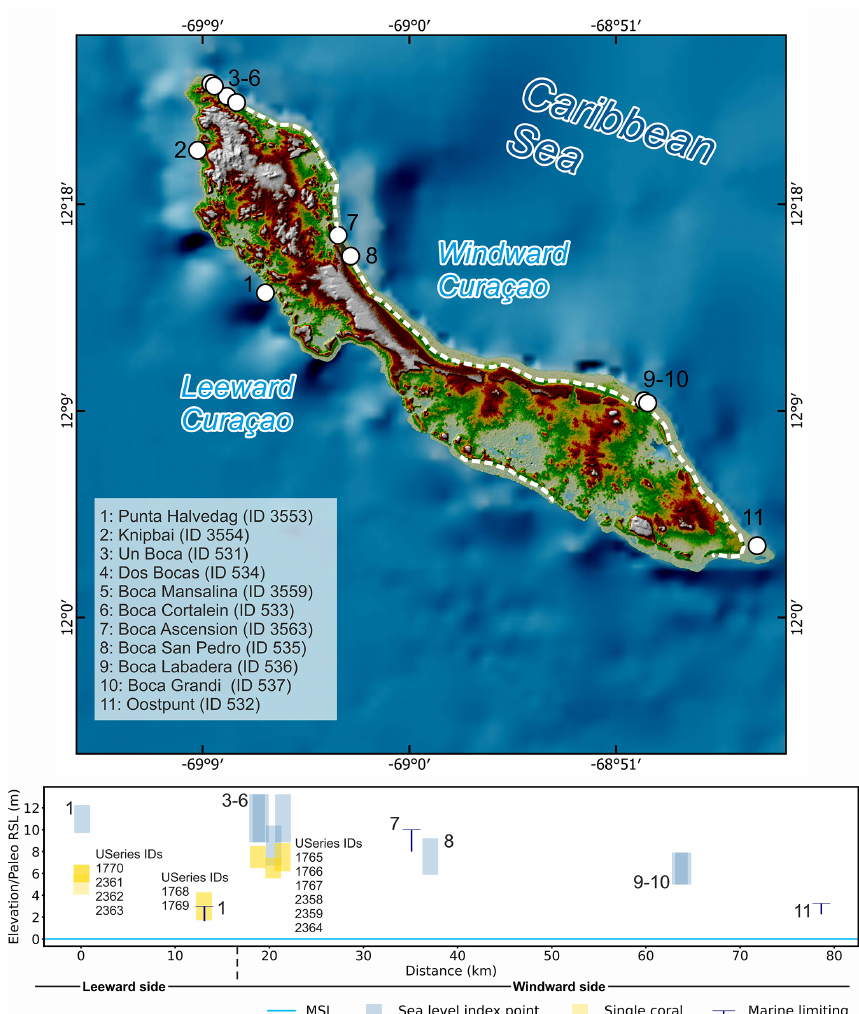
Figure 5. Last interglacial sea-level data in Curaçao. Upper panel: map of reported sites. The dashed line shows the location of the last interglacial terrace. The “single coral” data points represent coral elevations as reported in Chutcharavan and Dutton (2021). Background map compiled with data from GEBCO (https://doi.org/10.5285/836f016a-33be-6ddc-e053-6c86abc0788e) and SRTM 30m by NASA EOSDIS Land Processes Distributed Active Archive Center (LP DAAC, https://lpdaac.usgs.gov/). Lower panel: distance–elevation